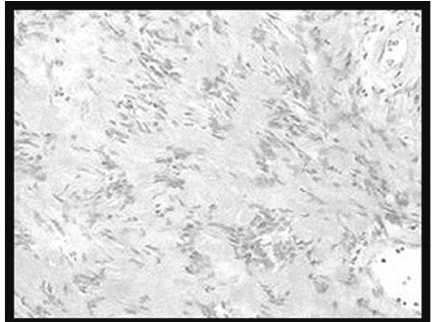
Figure 12: Histopathology slide of the surgical specimen is consis- tent with diagnosis of Antoni B type of